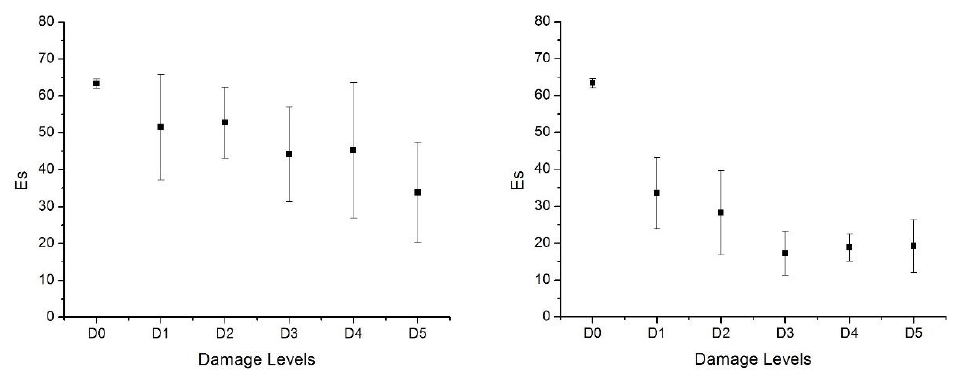
Figure 14. Mean and standard deviation of parameter E s . ( Left ) specimens subjected to incremental